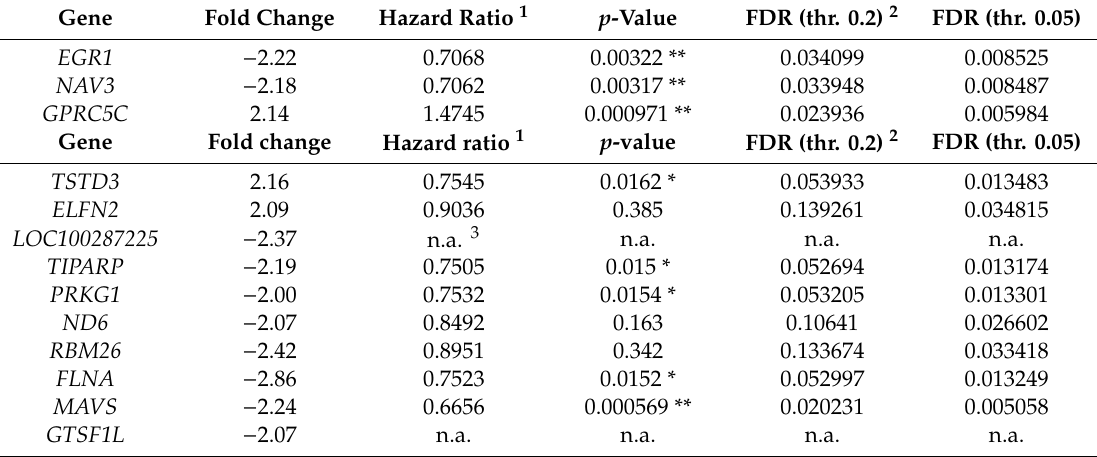
Table 2. Correlation of the expression of genes, di ff erentially expressed between SKOV-3-AA